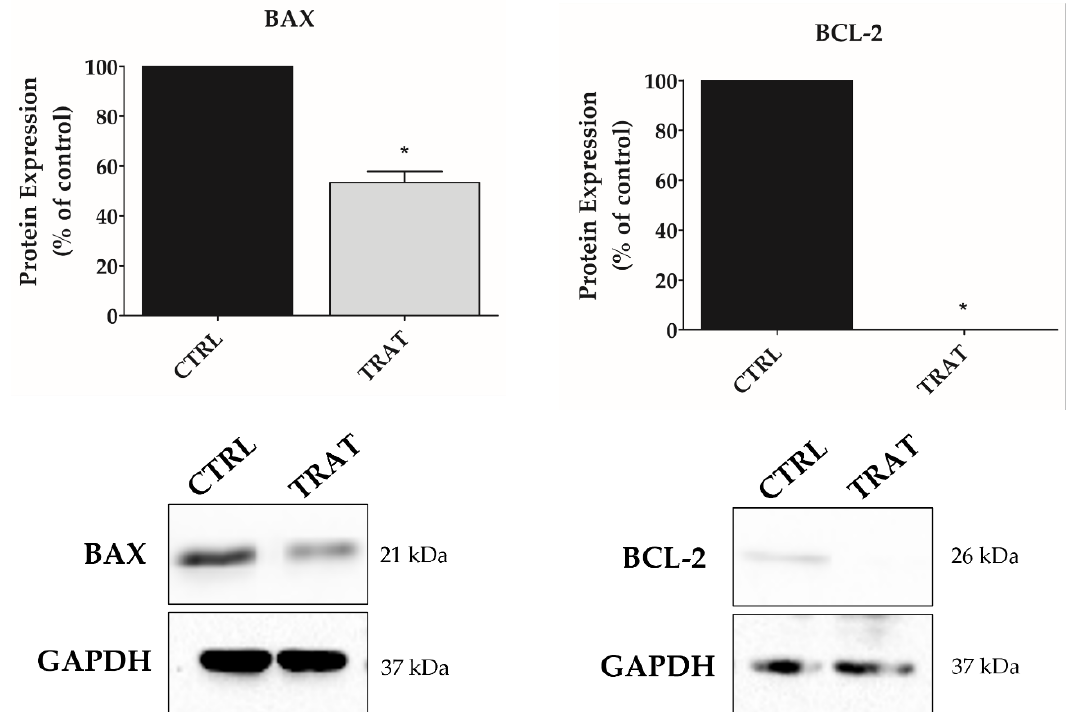
Figure 7. Indisulam alters the protein expression of BAX and BCL-2 in the pHGG cell line. SF188 cell was incubated under hypoxic conditions (CoCl 2 50 μM) for 24 h and treated with Indisulam (IC 50 ), or vehicle, for 48 h, and then BAX and BCL-2 protein expression was analyzed by Western blotting. In the analysis, the relative quantification was determined using ImageJ software. Relative values were compared to the control. * p < 0.05 indicates a significant difference between the BAX protein expression of the treated cells and the DMSO control, whereas * p < 0.01 indicates a significant difference between the BCL-2 expression of the treated cells and the control. GAPDH was used as endogen control. CTRL: control; TRAT: treatment with Indisulam.